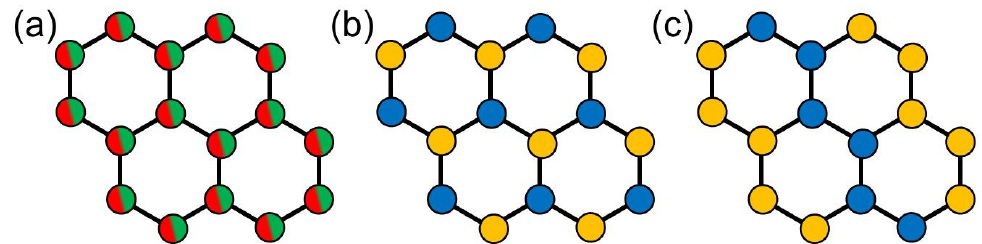
Figure 1. Schematic illustration of the different arrangements of M and M (cid:48) on the honeycomb lattice of M 2 P 2 S 6 . ( a ) Random distribution for M 2 + M (cid:48) 2 + P 2 S 6 . ( b ) Alternating/triangular arrangement and ( c ) zig-zag stripe like arrangement for M 1 + M (cid:48) 3 + P 2 S 6 . With M (cid:48) 3 + being a magnetic ion (e.g., V 3 + or Cr 3 + ) and M 1 + being non-magnetic (e.g., Cu 1 + or Ag 1 + ), the magnetic sublattices formed in M 1 + M (cid:48) 3 + P 2 S 6 extend the